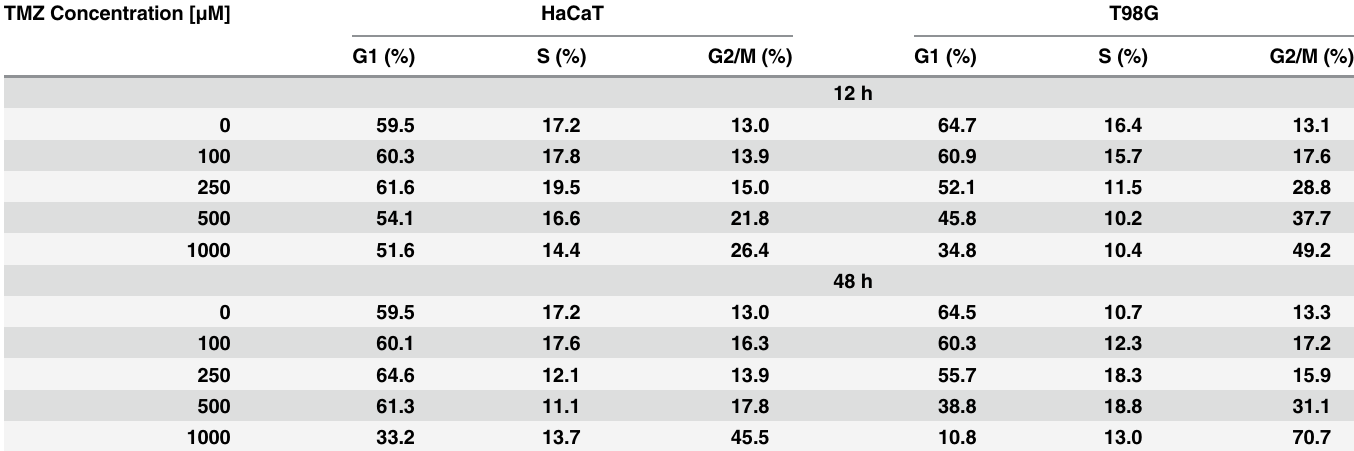
Table 1. The effect of TMZ on the HaCaT and T98G cell cycle lines. The percentage of cells in each phase of the cell cycle in cancer (T98G) versus non cancer (HaCaT) cell line after the drug treatment. The highest concentrations of TMZ (500 μ M and 1000 μ M) affected the most cell cycle phase distribution. The results are expressed as a mean ± SD. All experiments were done in triplicate. TMZ Concentration [ μ M]